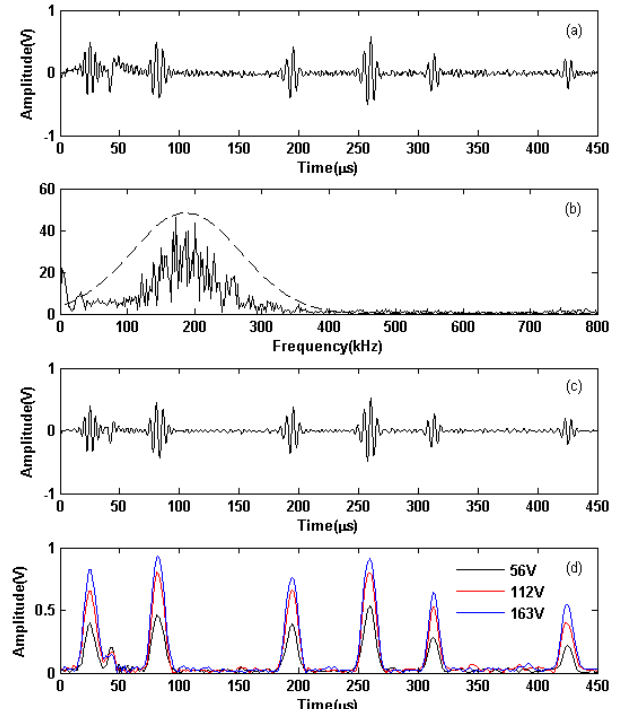
Figure 13. Inspection results in an Al plate when the exciting signals were with center frequencies of 180 kHz: ( a ) received signal when the exciting signals’ Vpp of 56 V; ( b ) spectra of the received signal when the exciting signals’ Vpp of 56 V (solid lines) and the Gaussian function (dashed lines); ( c ) filtered received signal when the exciting signals’ Vpp of 56 V; ( d ) Hilbert envelope of the filtered received signal when the exciting signals’ Vpp of 56 V, 112 V, and 163 V.